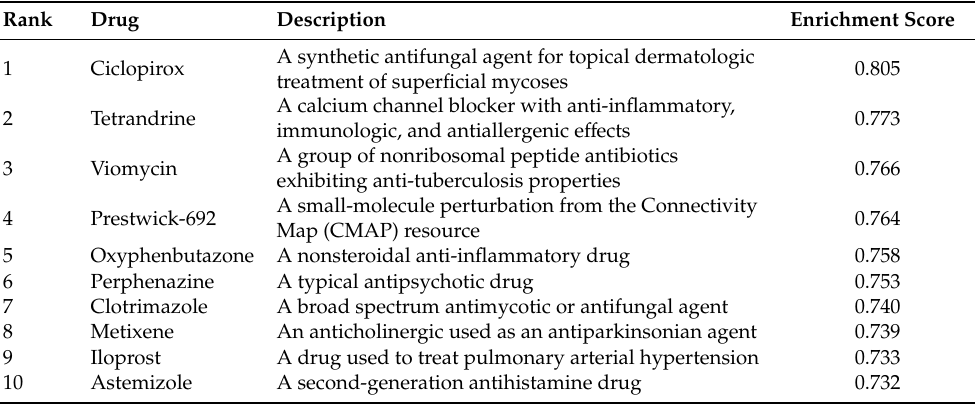
Figure 1. Flow chart of identification of a new inhibitor of HMGA2 using the GEO database and LINCS L1000 platform. The GSE136544 and GSE31687 microarrays were selected from the GEO database. The top 100 differentially expressed genes (100 upregulated and 100 downregulated genes) from the two GEO datasets were analyzed and then queried using the LINCS L1000 platform to predict the drugs that have the potential to inhibit HMGA2 expression. HMGA2—human high-mobility group A2; GEO—Gene Expression Omnibus; LINCS—Library of Integrated Network-based Cellular Signatures; CRC—colorectal cancer; RB—retinoblastoma. Table 1. Top 10 chemical perturbagens with positive enrichment scores for the gene expression signature of Prestwick-1082 .